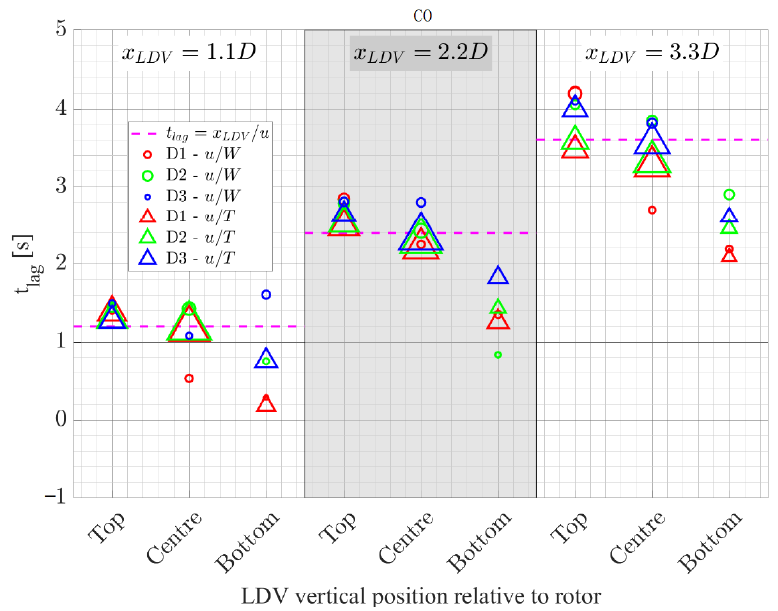
Figure 11. Comparison of lag between LDV, wave probe and thrust transducer signals obtained from cross-correlation for current-only cases. The size of a marker is relative to the R value of the cross-correlation function ranging from 0.2 to 0.8.